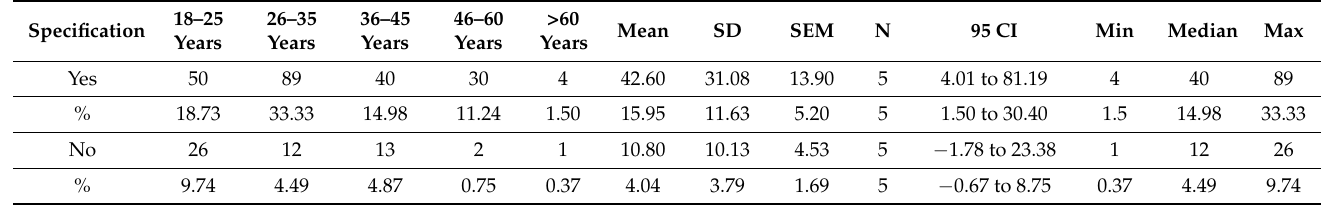
Table 7. Interest in food waste by age,